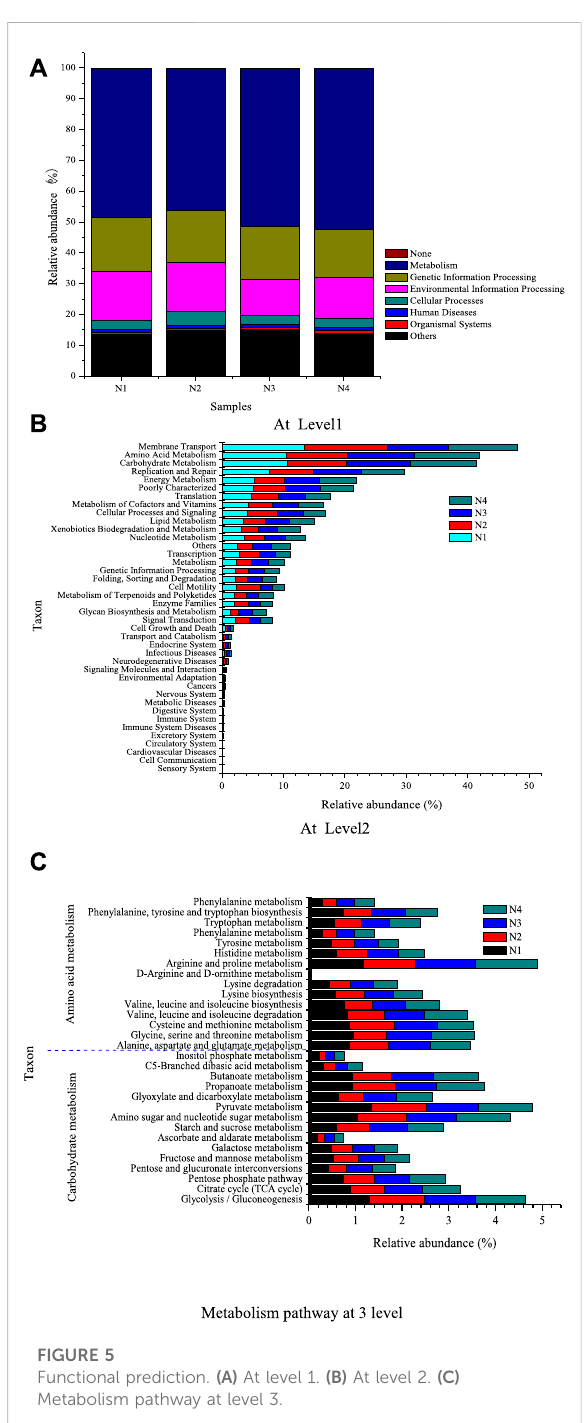
FIGURE 5 Functional prediction. (A) At level 1. (B) At level 2. (C) Metabolism pathway at level